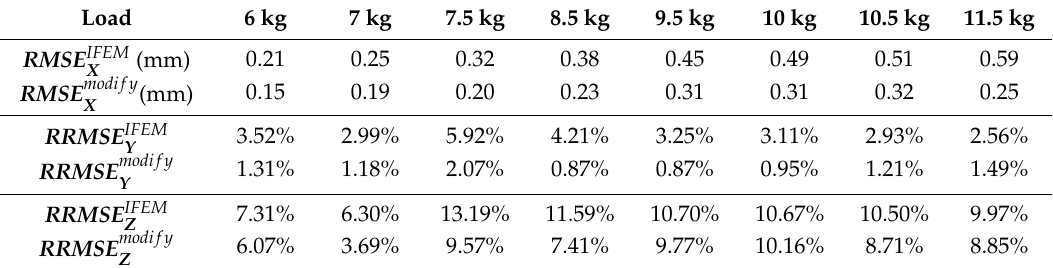
Table 5. Errors in the x, y, and z directions under di ff erent loads in the second element.